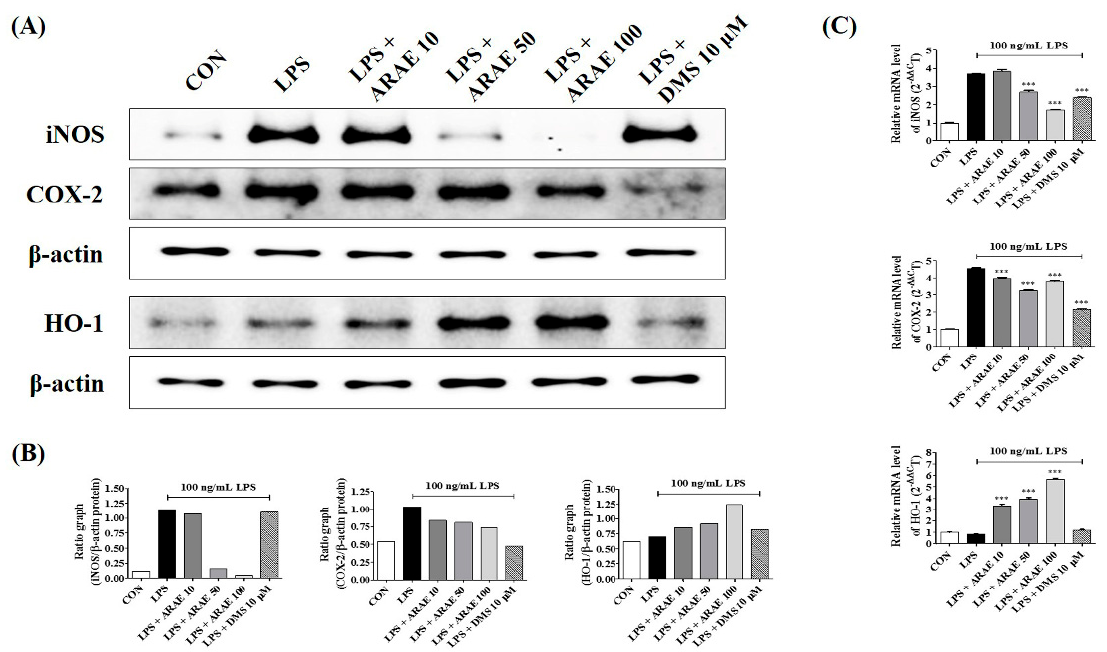
Figure 2. E ff ects of ARAE on ( A , B ) protein and ( C ) mRNA expression of inducible nitric oxide synthase (iNOS), cyclooxygenase (COX)-2, and heme oxygenase (HO)-1. Cells were seeded on a culture plate and pre-incubated for 18 h. Control cells were incubated with vehicle alone. Microglia were stimulated with LPS for 12 h (iNOS and COX-2), 6 h (HO-1 protein), or 3 h (HO-1 mRNA). ( B , C ) The histograms show protein and mRNA expression levels relative to those of the internal control. ( C ) Data represent the mean ± SEM of three independent experiments. CON: control; LPS: lipopolysaccharide; ARAE: Atractylodis Rhizoma Alba ethanolic extract; DMS: dexamethasone. *** p < 0.0001.